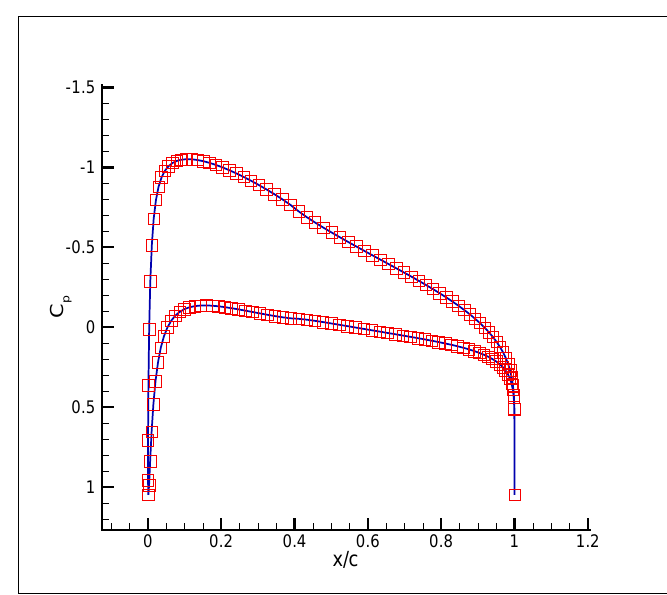
Figure 16. The pressure coefficient distribution for NACA2414 using FOILcom ( M ∞ = 0.435, α = 2 ◦ ).